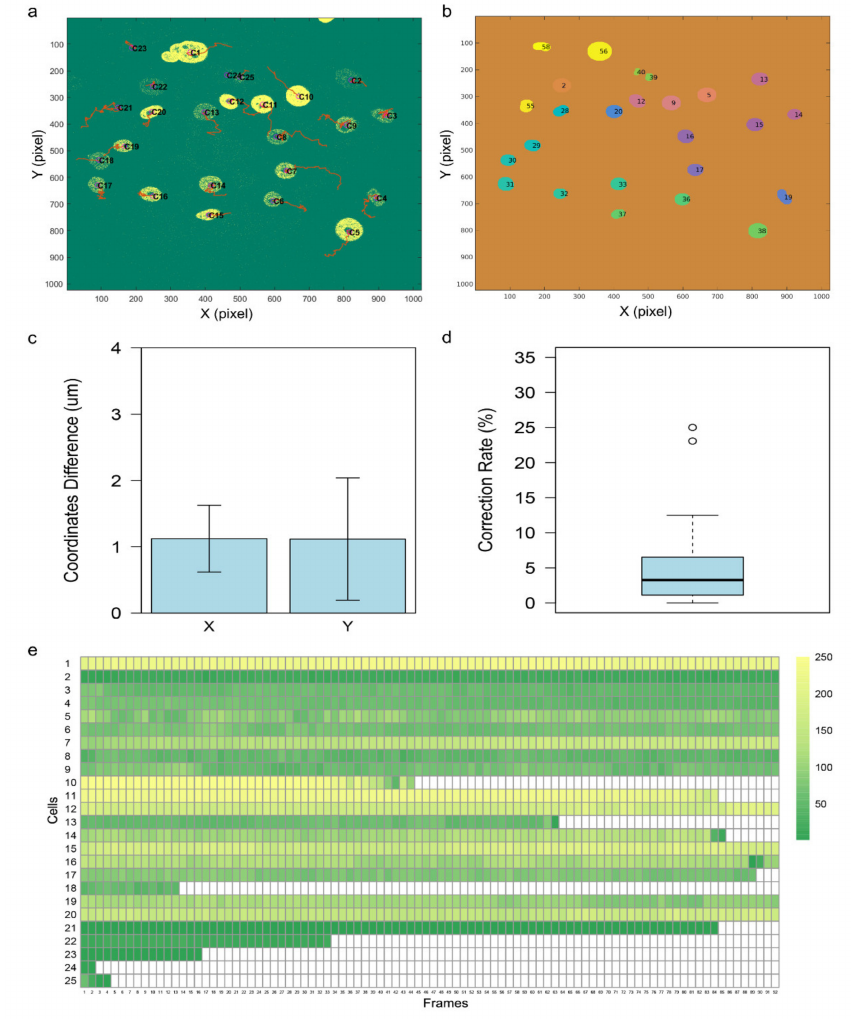
Figure 8. Tracking accuracy of CellMAPtracer. ( a ) Tracking outcome of CellMAPtracer over the Flue- N2DH-GOWT1_02_GT dataset. ( b ) The reference annotation of the Flue-N2DH-GOWT1_02_GT dataset computed using an inhouse code. ( c ) Location error plot; bars represent the mean coordinates difference between the trajectories generated by CellMAPtracer and the true coordinates on the x and y axes based on the ground truth ( n = 25). ( d ) Boxplot showing the correction rates (manual intervention rates) of all tracked cells. ( e ) Intensity heatmap showing the intensity profiles of all the tracked